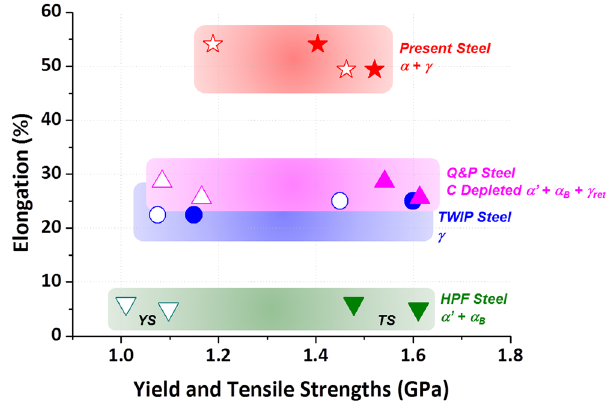
Figure 6. Comparison of present duplex steels with conventional ultra-high-strength steels. Room-temperature tensile properties and constituent phases of hot press forming (HPF) steels, TWinning-Induced Plasticity (TWIP) steels, and Quenching & Partitioning (Q&P) steels showing yield strength above 1 GPa. In HPF steels composed of full martensite matrix, the yield and tensile strengths are very high above 1.0 and 1.5 GPa, respectively, whereas their elongation is low below 8%. When nano-twinned structures are formed by relatively- low-temperature recovery treatments in high-Mn TWIP steels, the yield strength is enhanced above 1.0 GPa, but the elongation is reduced below 25%. Low~medium-Mn Q&P steels show ultra-high strengths by using the TRIP of retained austenite, while their elongation is lower than